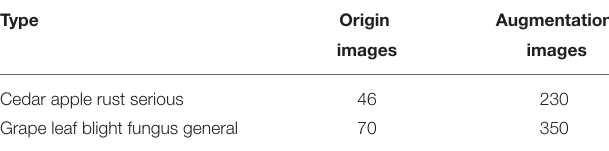
TABLE 1 | Weak dataset